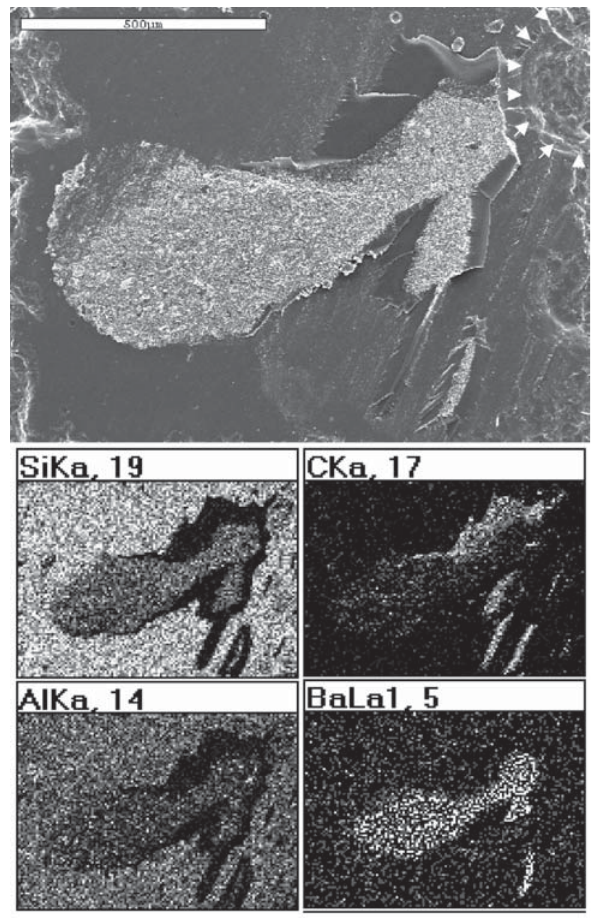
FIGURE 7- SEM image (top) and X-ray elemental maps of fracture surface of IPS Empress ceramic (Ivoclar AG, Schaan, Liechtenstein) bonded to resin composite (Z100, 3M Dental Products, St Paul, USA). The label at the top of X-ray maps indicates the elements and their intensity. The critical flaw is indicated by the white arrows at the top right corner of the SEM micrograph (x100). The fracture starts along the ceramic/adhesive interface, propagates through the adhesive resin to reach the resin composite-adhesive interface (Failure Mode 5). From Della Bona, et al. 27 ,